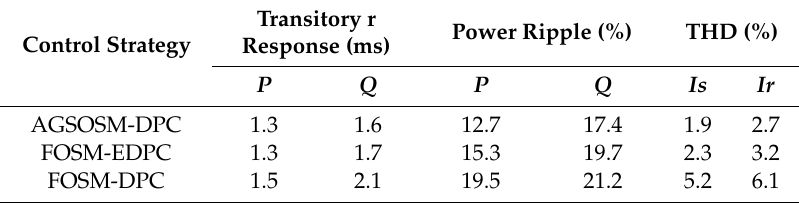
Table 2. Quantitative comparison under the three control